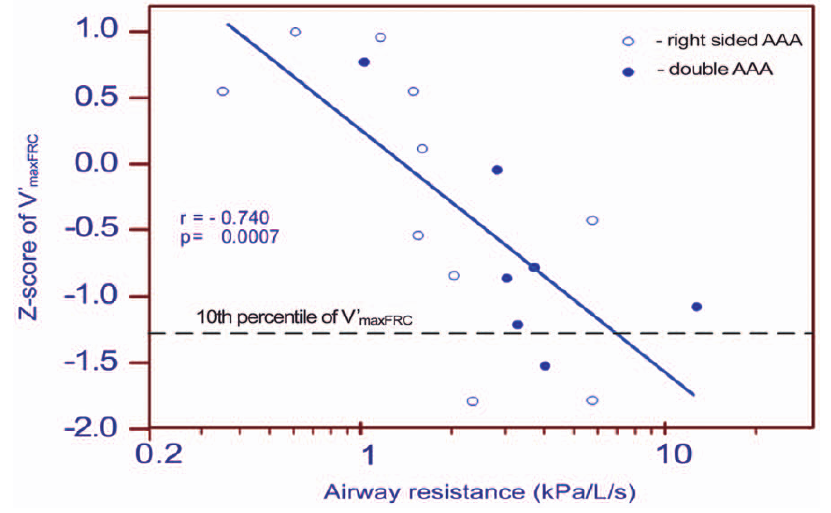
Figure 3. Correlation between Z-score of V 9 max FRC and R aw of infants with AAA.